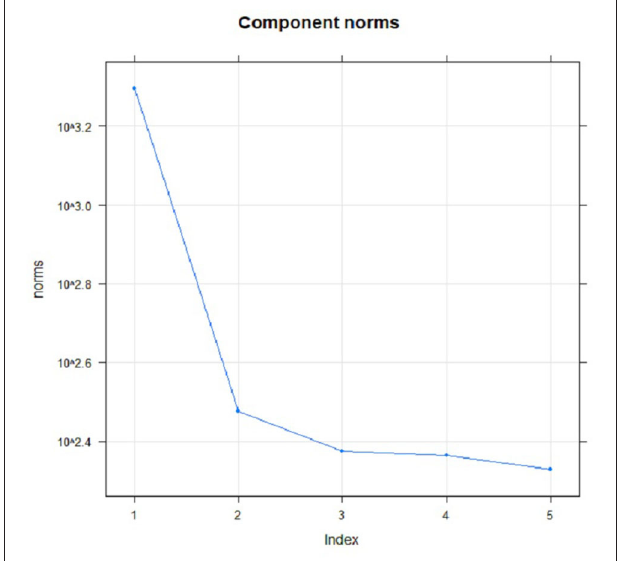
FIGURE 9 | Logarithms of five eigenvalues.